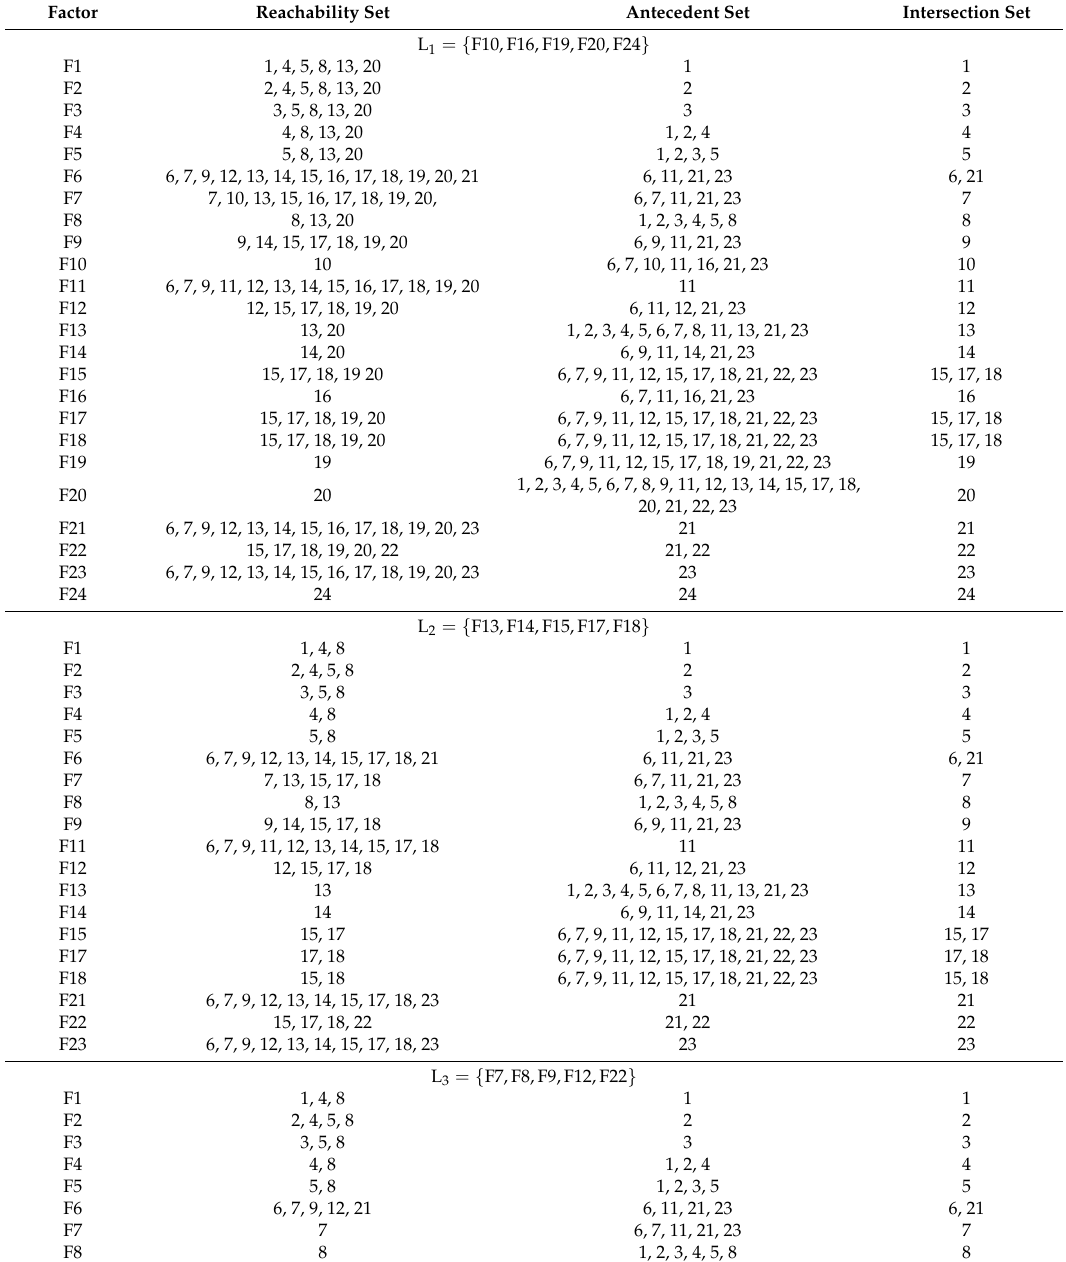
Table 6. Level partition of reachability